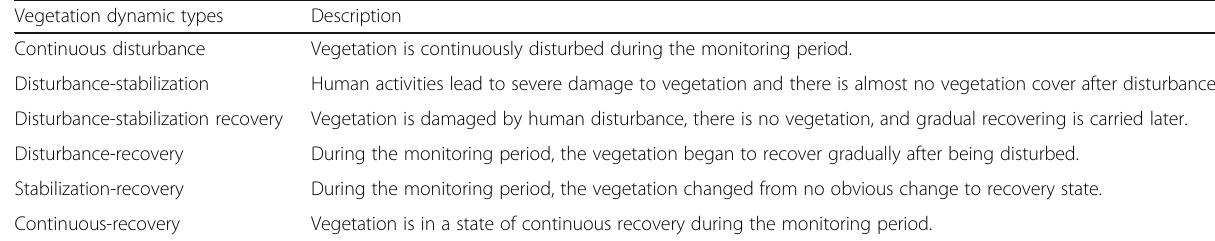
Table 1 Description of vegetation dynamic types